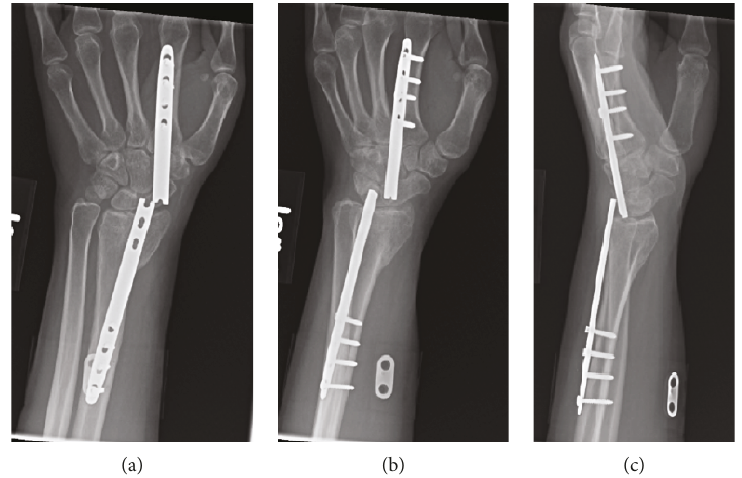
Figure 3: Return to clinic. X-rays on return to clinic, 12.5 months after dorsal bridge plate